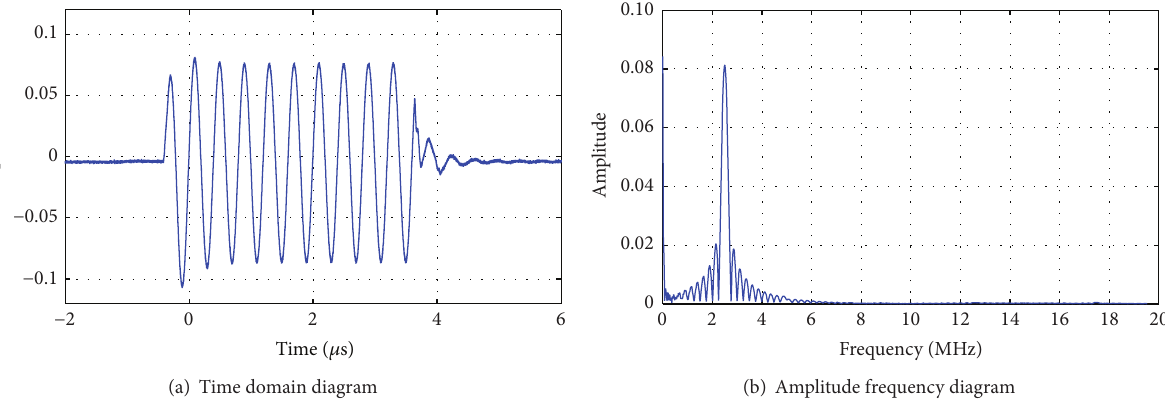
Figure 5: Time domain and amplitude frequency diagrams of exciting signal.